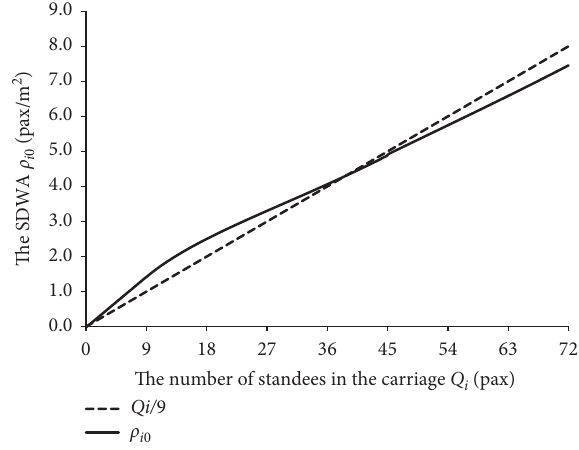
Figure 4: Variation trend of ρ